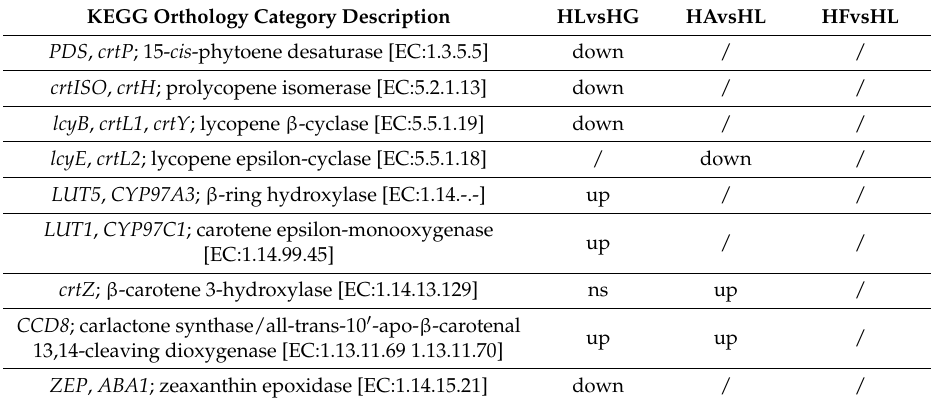
Table 4. Up-and-down regulated genes related to the carotenoid biosynthesis pathway. KEGG Orthology Category Description